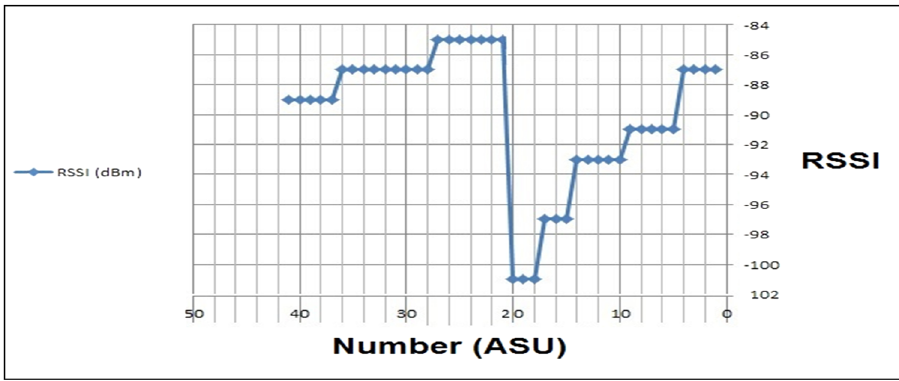
Figure 10: Current connection and reconnection with network BTS depend on the RSSI